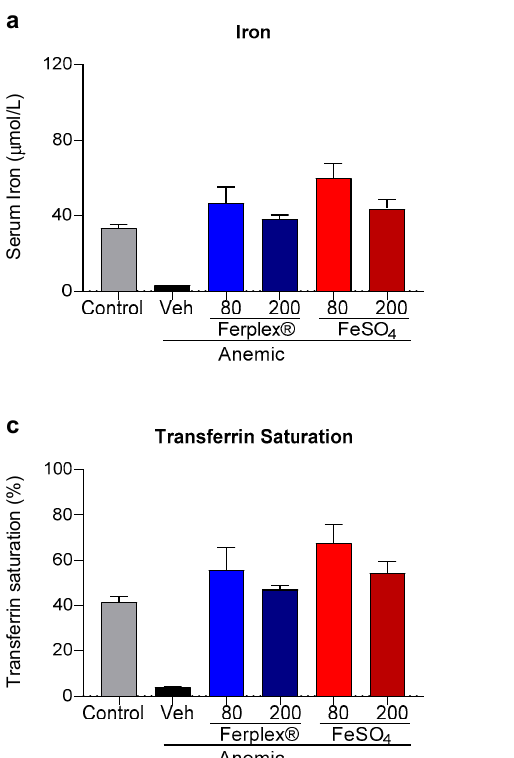
Figure 5. Iron and transferrin analysis at study termination. Concentration of iron ( a ) and transferrin ( b ) recorded in serum at study termination. ( c ) Percentage of transferrin saturated. Data are presented as mean ± SEM. At termination there was no significant difference between treatment groups and control. Data were analyzed with a Kruskal-Wallis test followed by Dunnett’s multiple comparison test. N = 6 to 8 (as indicated in the Table 2). Veh = vehicle.